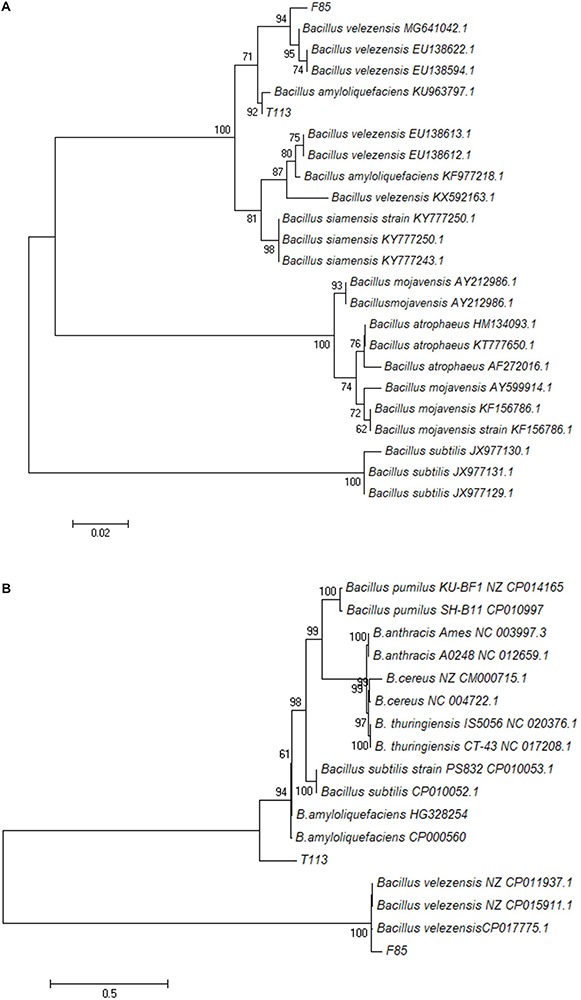
Phylogenetic trees based on the partial nucleotide sequence of gyrA
(A) and 22 housekeeping genes (B). A Maximum-likelihood phylogenetic tree of F85 and T113 was constructed using MEGA 7.0. The numbers at nodes indicate levels of bootstrap support (%) based on a Maximum-likelihood analysis of 1000 re-sampled datasets; only values greater than 50% are provided.